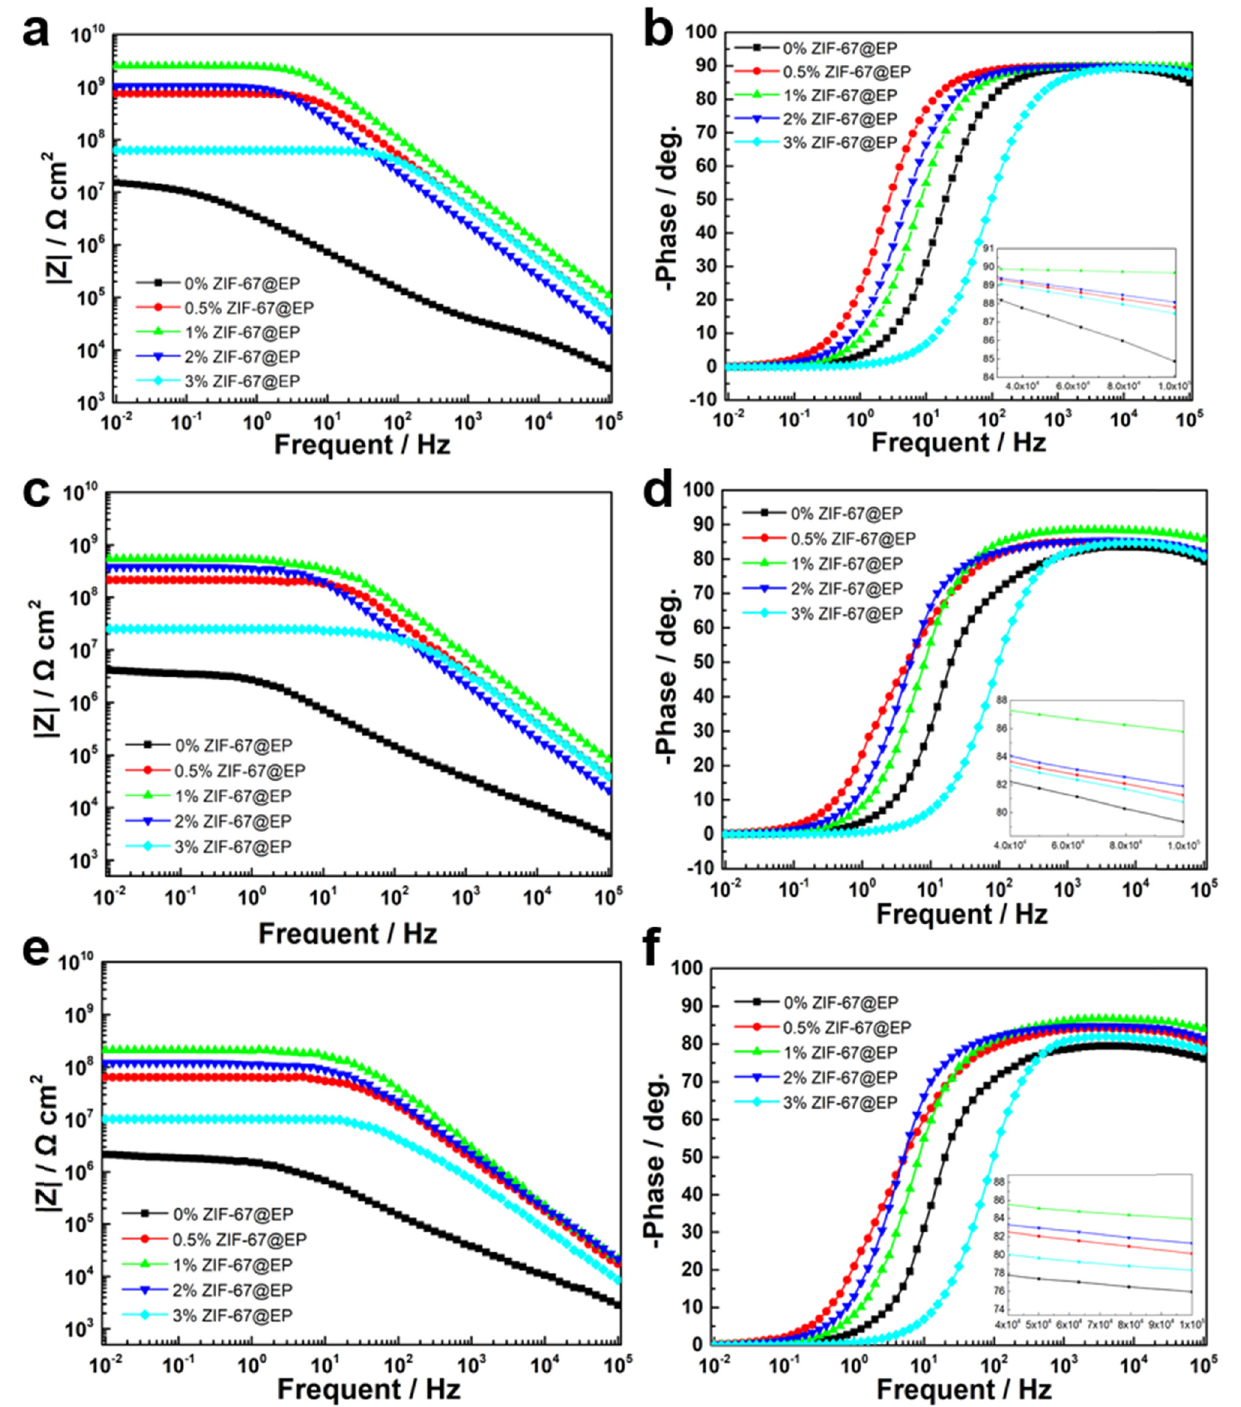
Figure 8: Bode impedance and bode phase plots of composite coatings at di ff erent immersion times: 0 day ( a and b ) , 7 days ( c and d ) , and 14 days ( e and f )